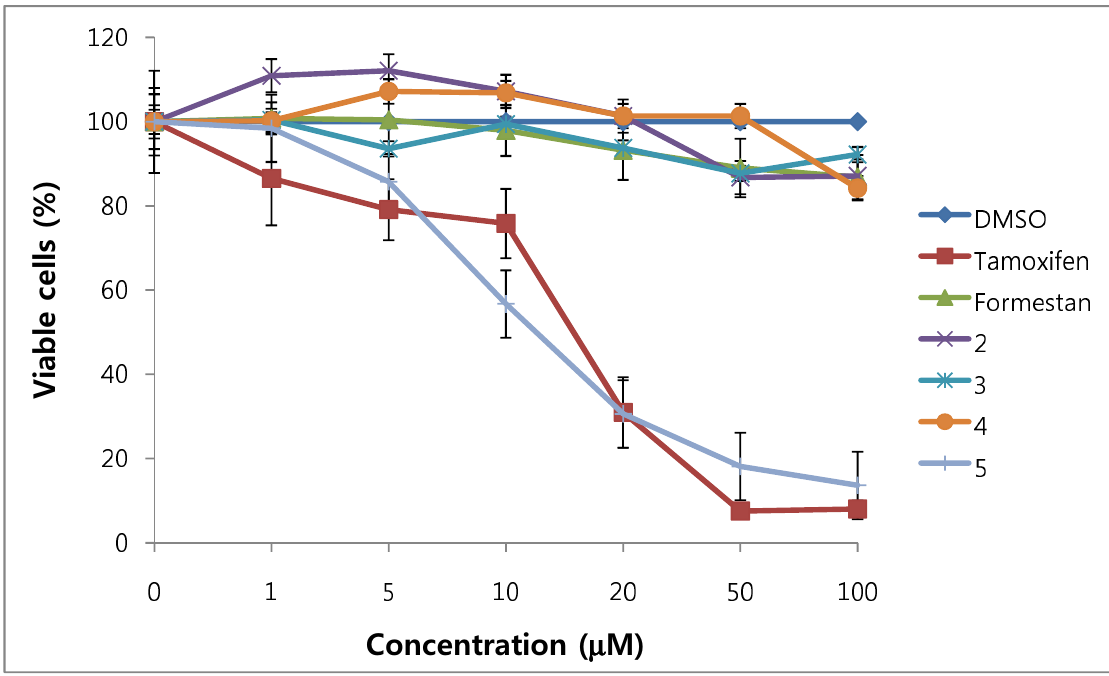
Figure 4. Cytotoxic effects of compounds 2 - 5 in MDA-MB231 cells (ER-negative breast cancer